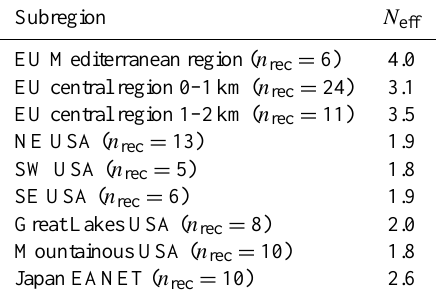
Table 1. Number of effective models N eff for the subregions ob- ject of the analysis – with reference to Fig. 2 of Fiore et al. (2009) top panel, based on corr (d i ,d j ) . The n rec is the number of surface receptors used for